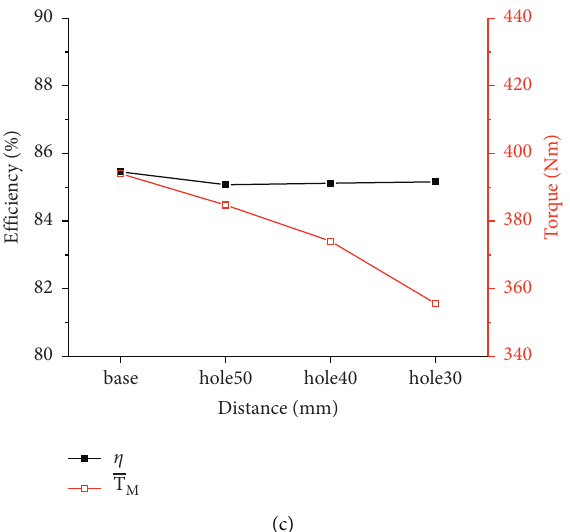
Figure 20: The influence of the rotation speed (a), installation angle (b), and edge distance (c) of the stirring blade on the pump suction.